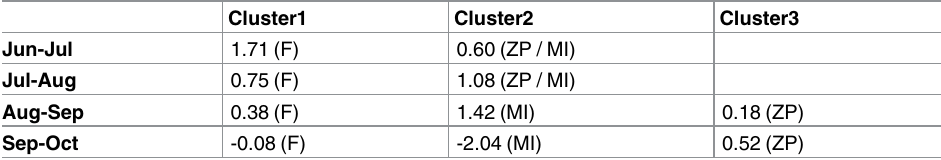
Table 1. Growth rates [mm day -1 ] of perch in different